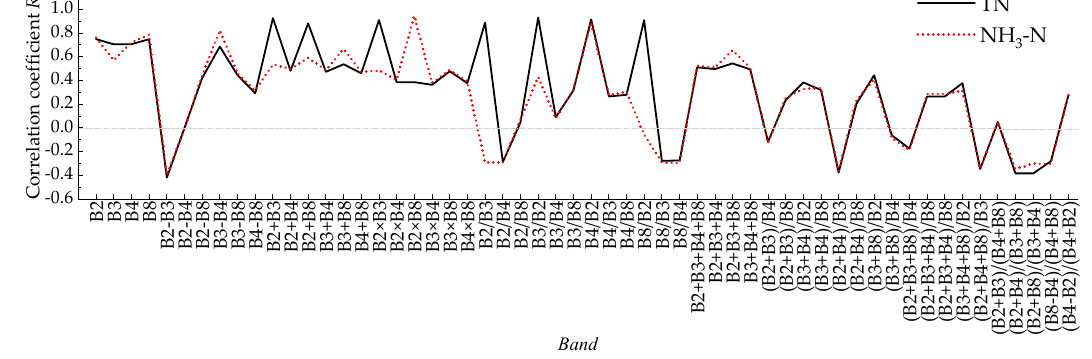
ffi cients of di ff erent band combinations. TN, total Figure 4. Correlation coefficients of different band combinations. TN, total nitrogen. Figure 4. Correlation coe